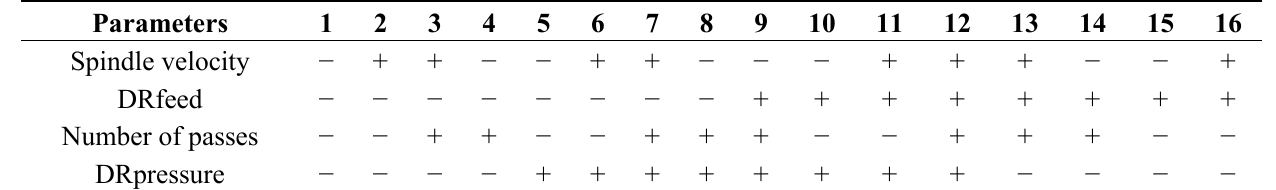
Table 2. Combination of parameters used for DR treatment of 16